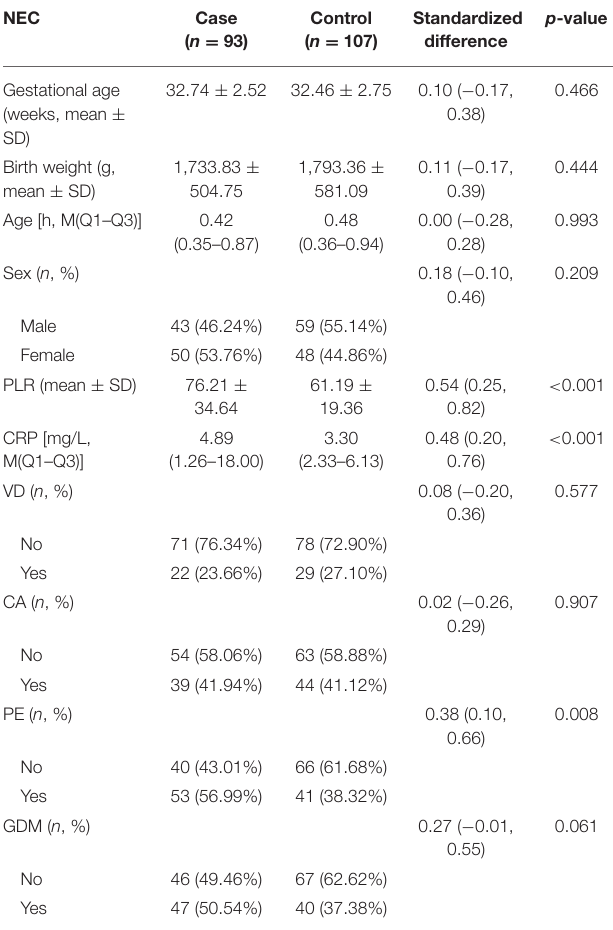
TABLE 1 | Baseline characteristics of participants ( N =